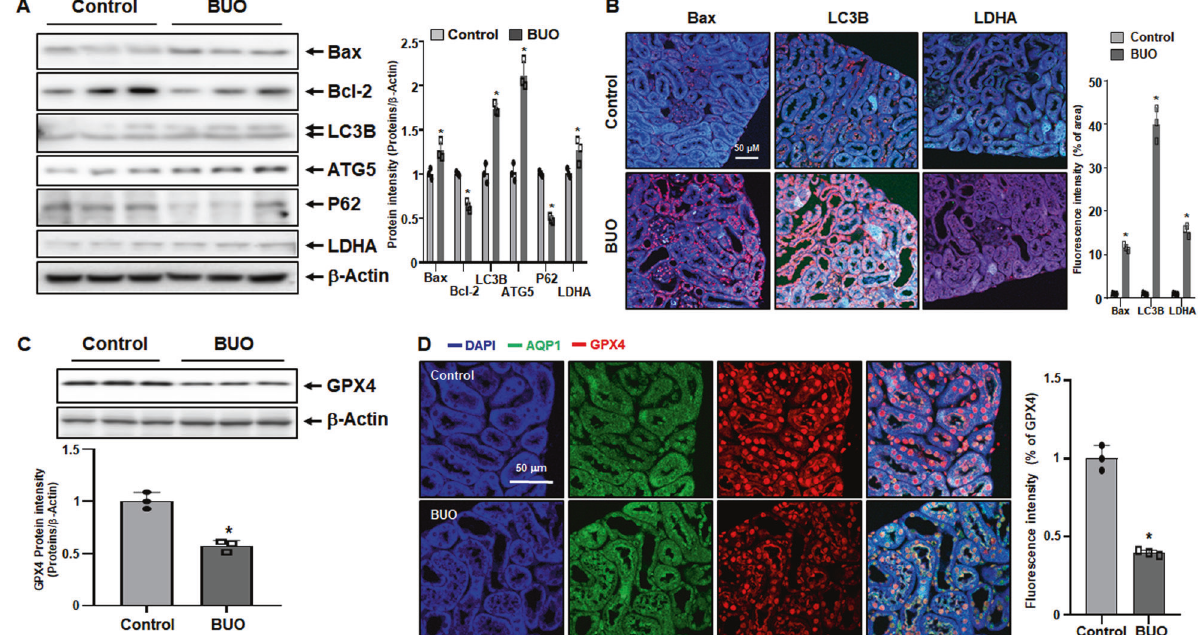
Fig. 2 Increased cell death and decreased GPX4 expression in bilateral ureteral obstruction (BUO) mouse kidneys. ( A ) Expression levels of cell death-related proteins Bax, Bcl-2, LC3B, ATG5, P62 and LDHA in BUO and control mice (immunoblotting). The values for the control group were set to 1. ( B ) Immuno fl uorescence staining of Bax, LC3B, and LDHA in control and BUO mouse kidneys. The expression of cell death- related proteins are shown in red, and nuclei are marked in blue (DAPI). The bar graph on right shows the fl uorescence intensity (control is